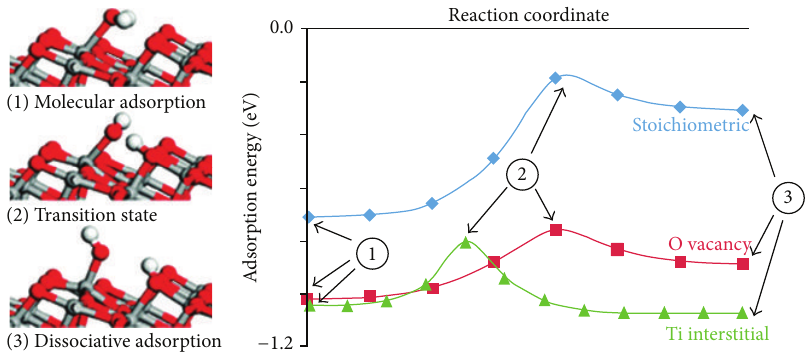
Figure 13: The water adsorption state on O vacancy, Ti interstitial and stoichiometric surface [111].